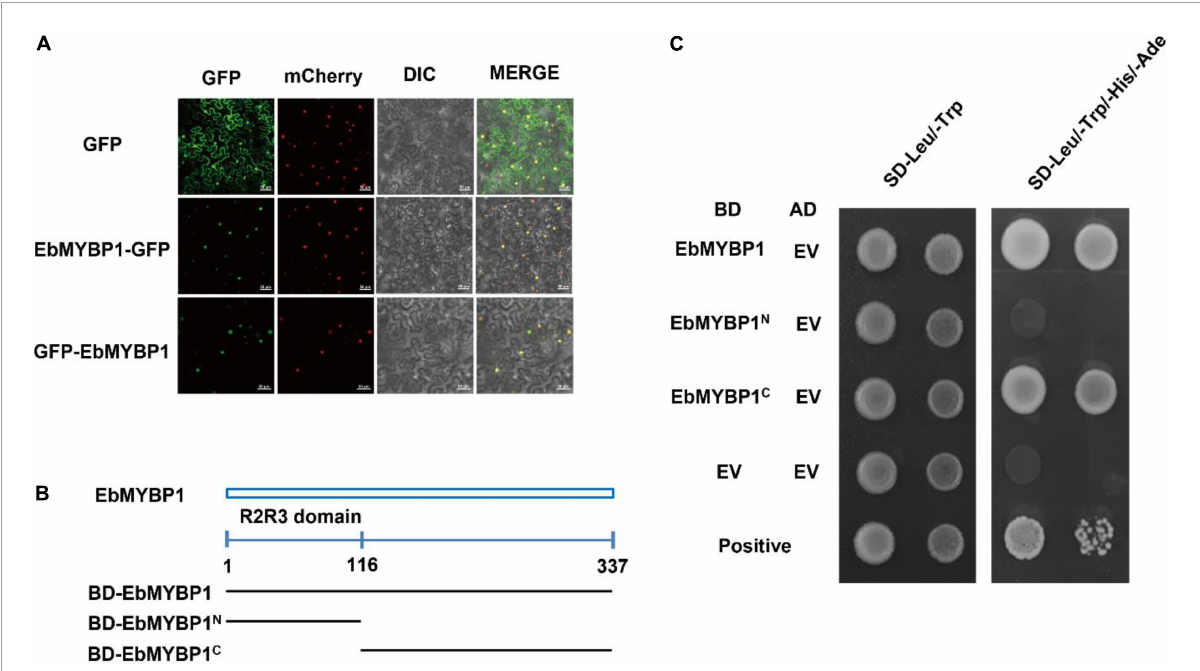
FIGURE3 Analysis of the subcellular localization and transactivation activity of EbMYBP1. (A) Subcellular localization of EbMYBP1 in N. benthamiana leaves. EbMYBP1 fused to the N-terminal of GFP (middle) or C-terminal of GFP (lower) under the control of the 35S promoter. The HY5-mCherry was used as nucleus marker. Differential interference contrast (DIC) and GFP, mCherry fluorescence images as well as merged images are shown. At least three individual experiments were performed for each combination with the similar results. Bars = 50 µ m. (B) Schematic diagrams illustrate the different portions of EbMYBP1 ORF that were fused to the yeast vector pGBKT7. (C) Transactivation activity of the EbMYBP1 protein in yeast. The transformed cells were selected on SD/-Trp medium (left panel) and SD/-Trp/-His medium (right panels). Three biological experiments produce similar